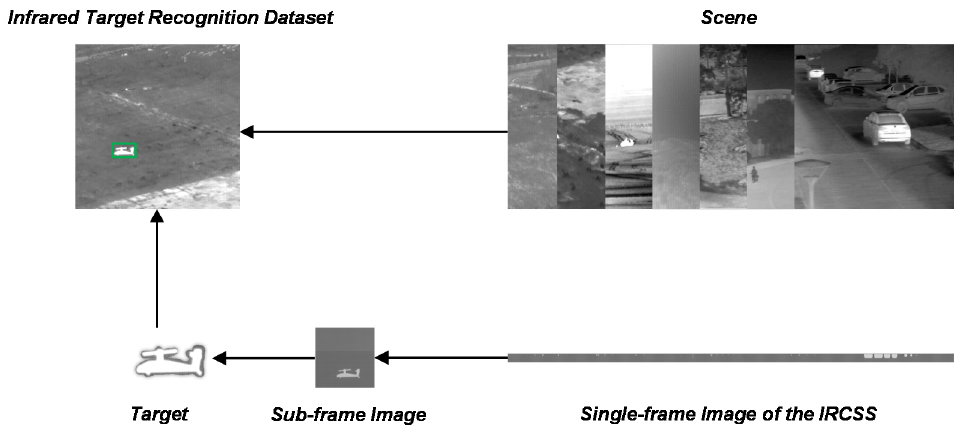
Figure 4. The process of building the infrared target recognition dataset. After getting the sub-frame image, we separated the target. The target was then embedded into the scene images.